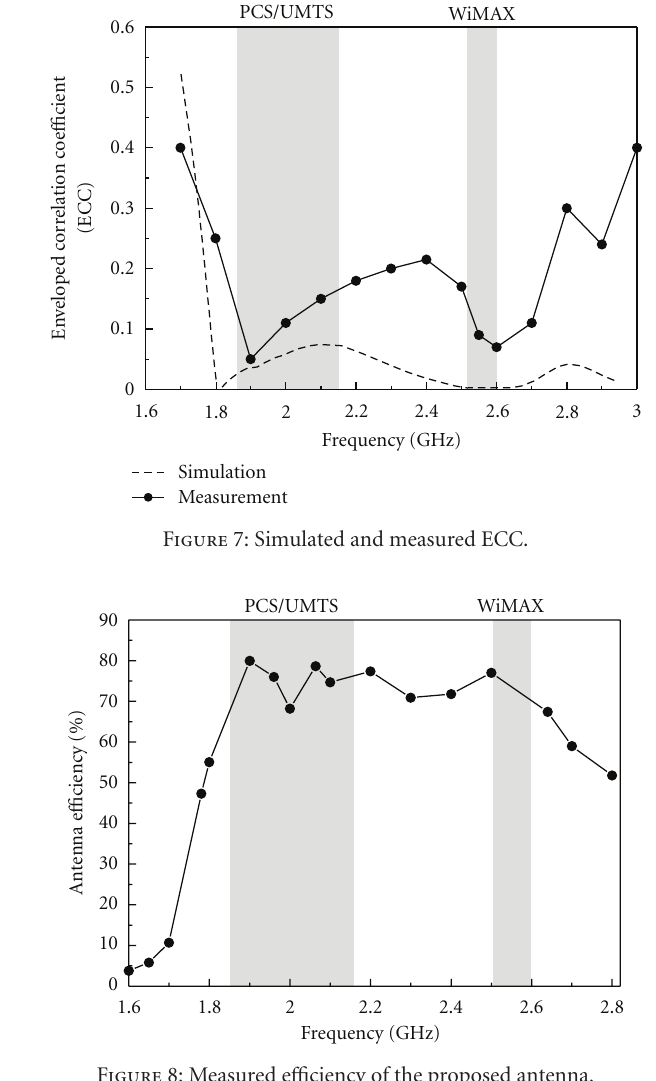
Figure 8: Measured e ffi ciency of the proposed